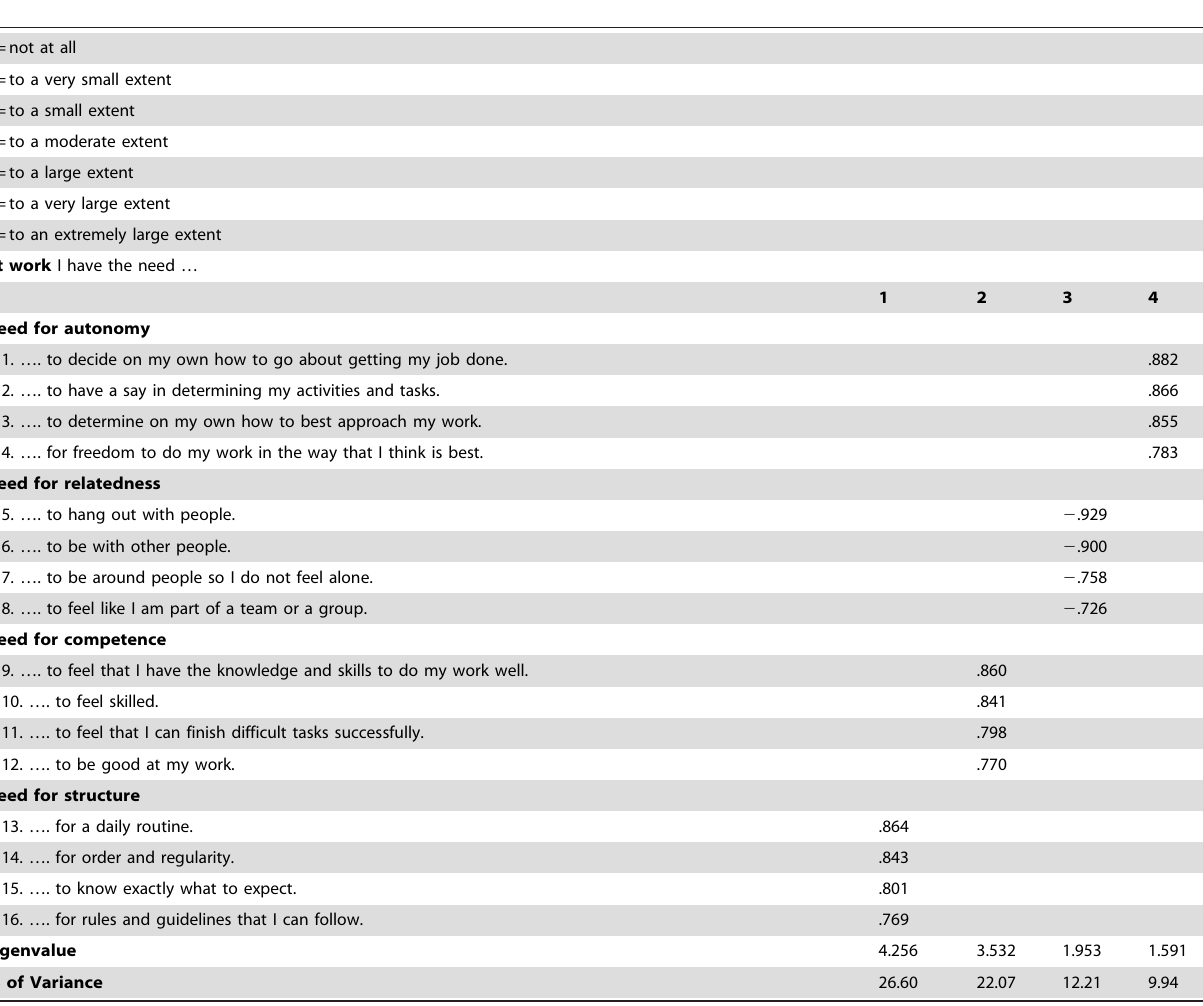
Table 2. Specified Four-Factor Solution of a Principal-Components Analysis of the Need Strength